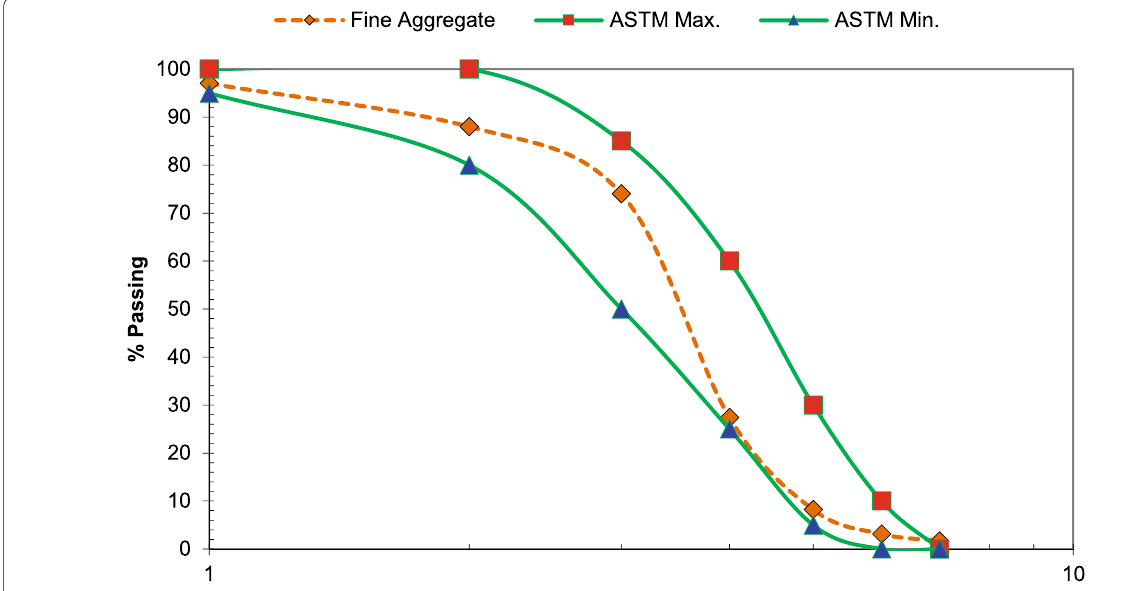
Fig. 2 Particle size distribution curve of sand.